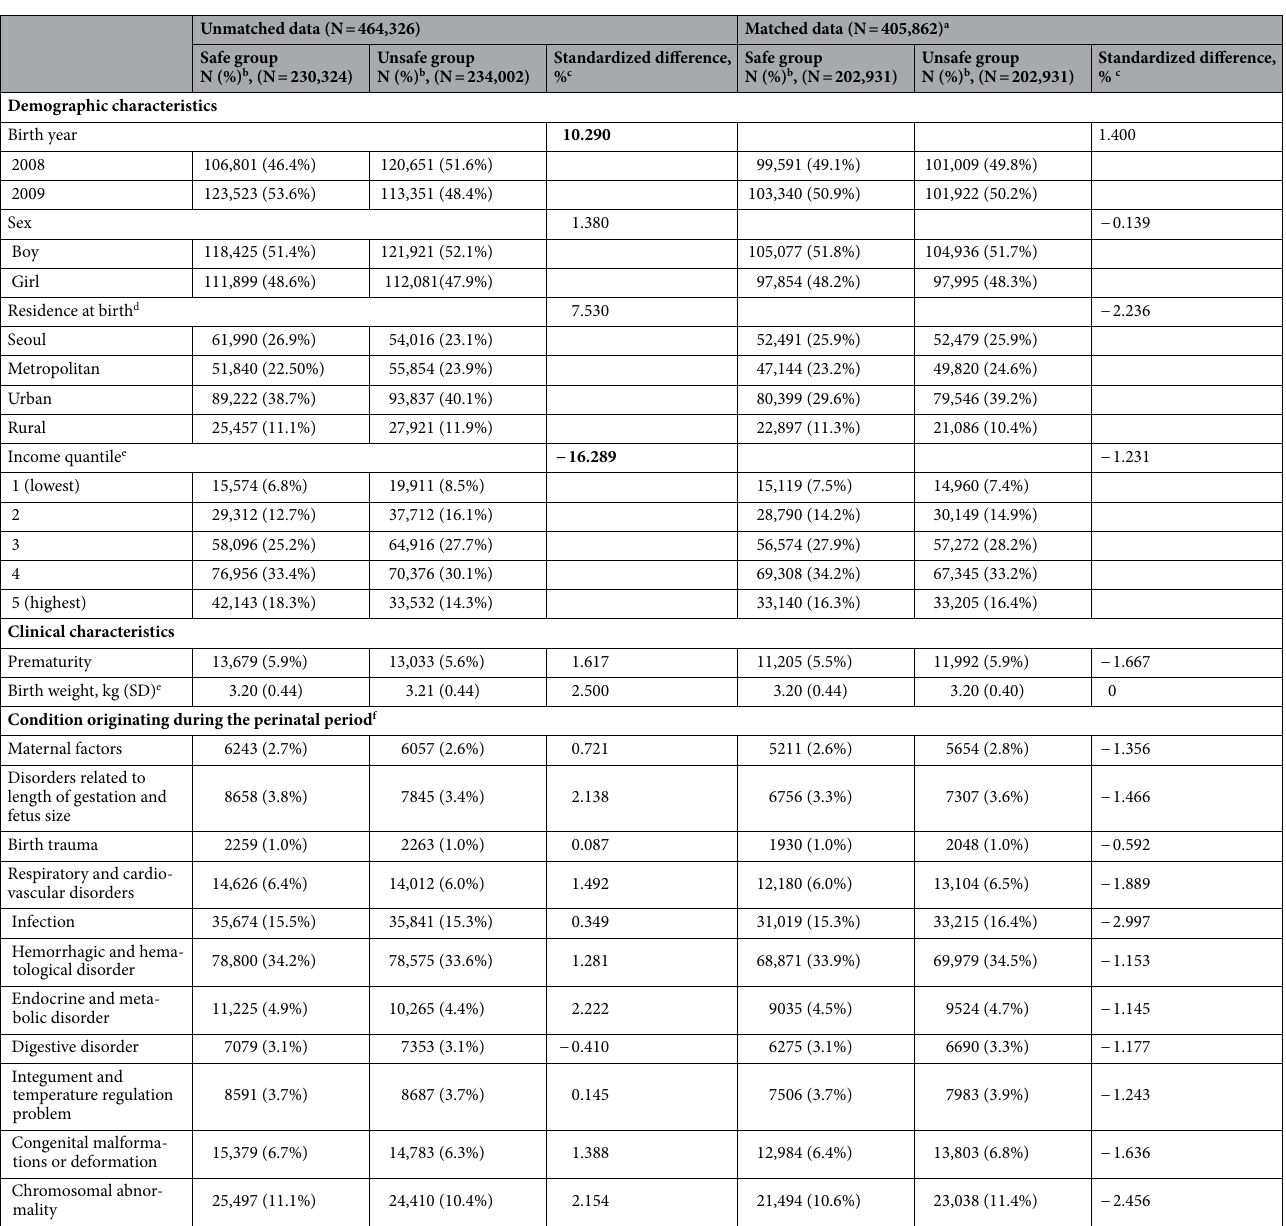
Table 1. Demographic and clinical characteristics of children in the main cohort. N number, SD standard deviation. Unless otherwise specified, baseline characteristics were assessed on the date of birth. a Matched using inverse probability of exposure matching, based on propensity scores. The propensity score was estimated using multivariable logistic regression with covariates chosen a priori (Table S2). b Values are reported as N (%) unless otherwise indicated. c The difference between the groups divided by the pooled standard deviation; a value greater than 10% was considered meaningful. d Obtained from the First National Health Screening Program of Infants and Children at age 4 to 6 months. e Average income quintile of the neighborhood at birth. f Conditions that originated during the perinatal period were identified by ICD-10 codes (Supplementary Appendix 3). Significant values are in